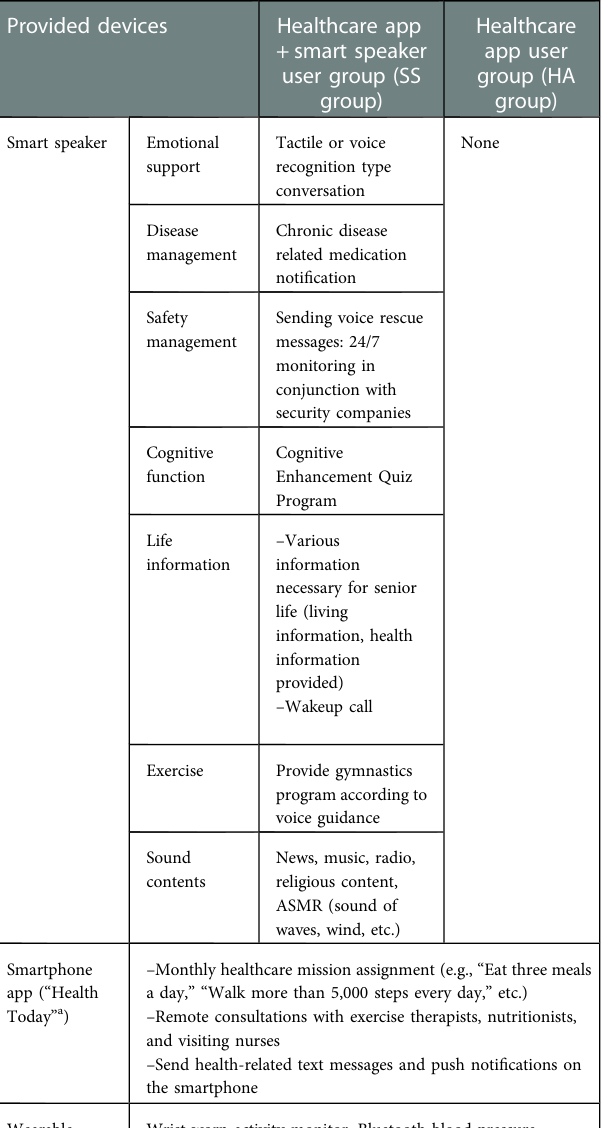
TABLE 1 Functions of healthcare devices by intervention groups. Provided